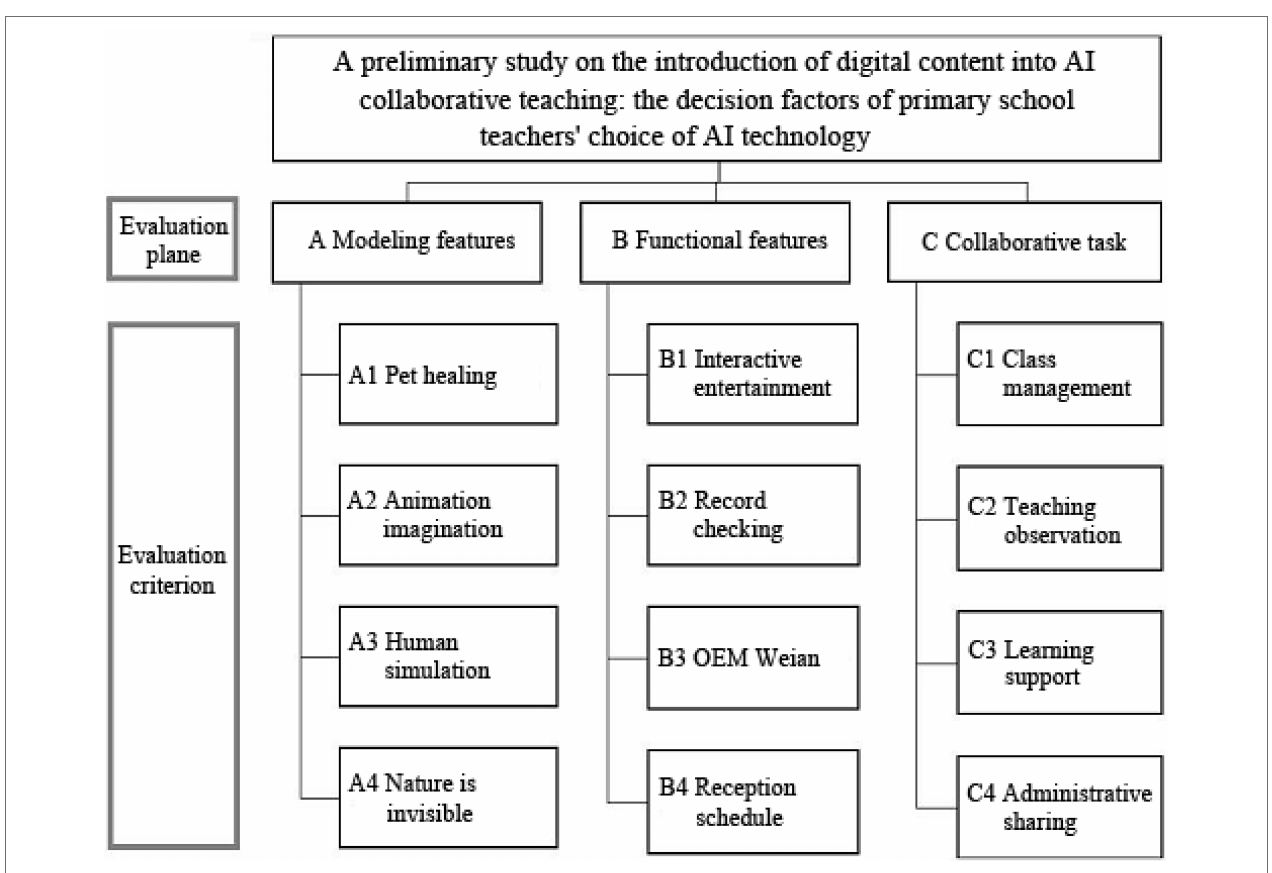
FIGURE 2 | Research hierarchical structure.